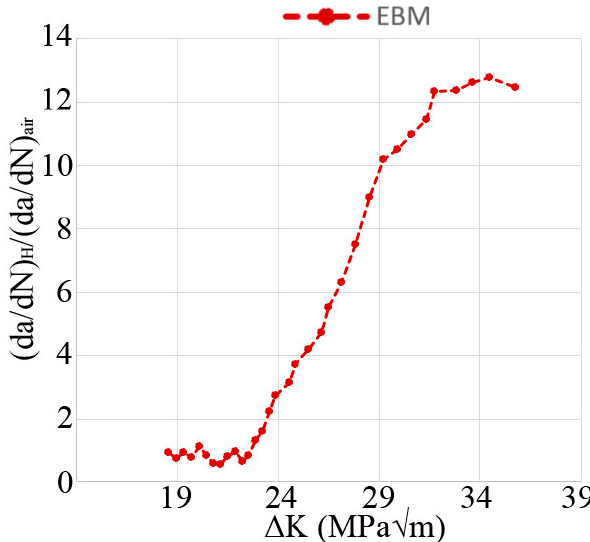
Figure 5. Relative crack propagation rate between hydrogen and air-tested material versus ∆ K. At 23 (cid:1839)(cid:1842)(cid:1853)√(cid:1865) the relative crack propagation increases steadily while reaching a plateau at 31 (cid:1839)(cid:1842)(cid:1853)√(cid:1865) .